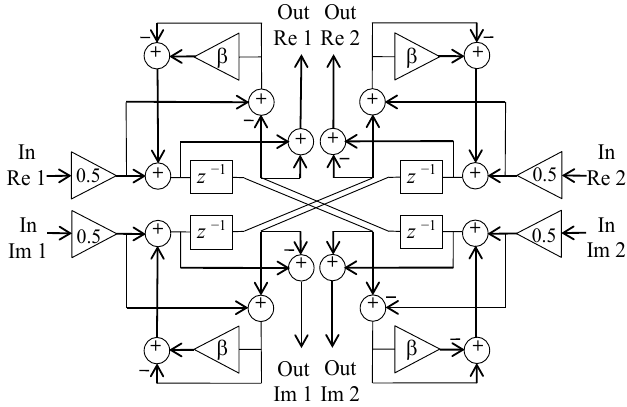
Fig. 7. Bilinear orthogonal bicomplex LS 11-based